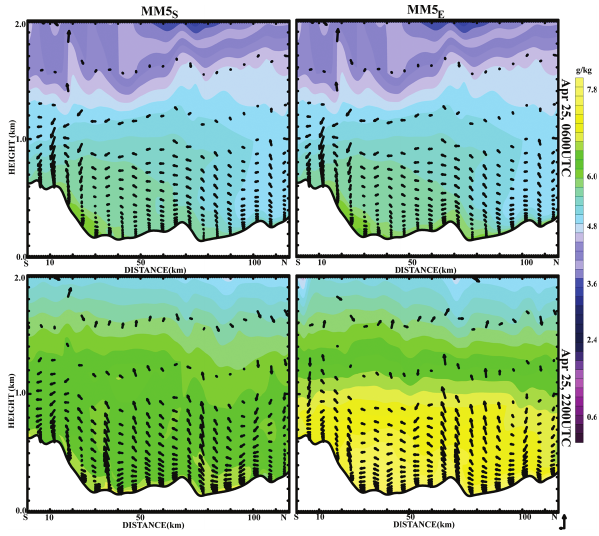
Fig. 11. North-South cross section of water vapour mixing ratio on 25 April at 06:00UTC (upper panels) and 22:00UTC (lower pan- els). Left panels: MM5 S run; right panels: MM5 E